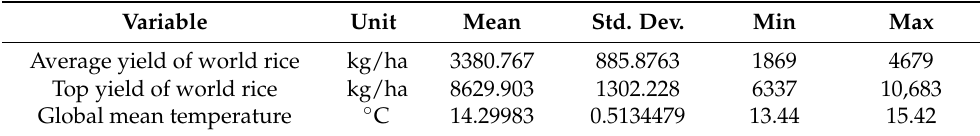
Table 1. Descriptive statistics of average and top yields of world rice and global mean temperature from 1961 to 2020.